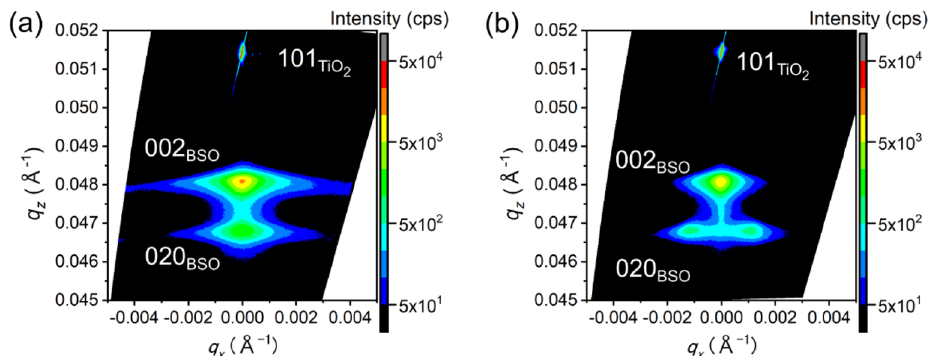
Figure 2. RSMs for BSO/(101)Nb:TiO 2 with a thickness of 300 nm. X-rays were introduced parallel to ( a ) [10–1] TiO2 , and ( b ) [010] TiO2